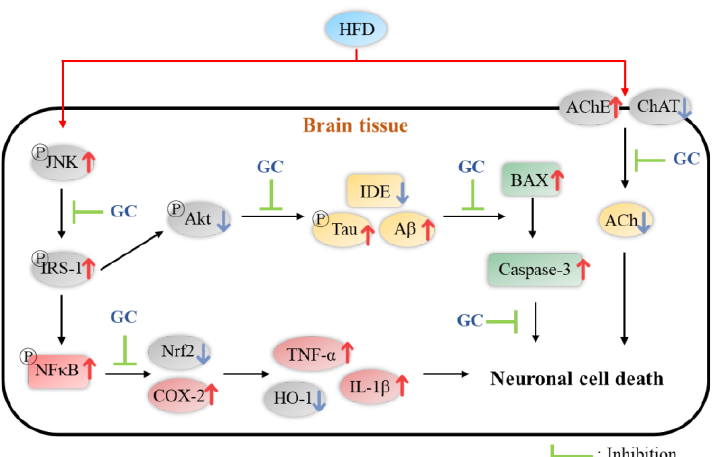
Figure 12. A schematic illustration shows the immunomodulatory effect of 80% ethanolic extract from Gimcheon 1ho (GC) cultivar walnut ( Juglans regia ) on HFD-induced neuroinflammation in mice brain tissues.